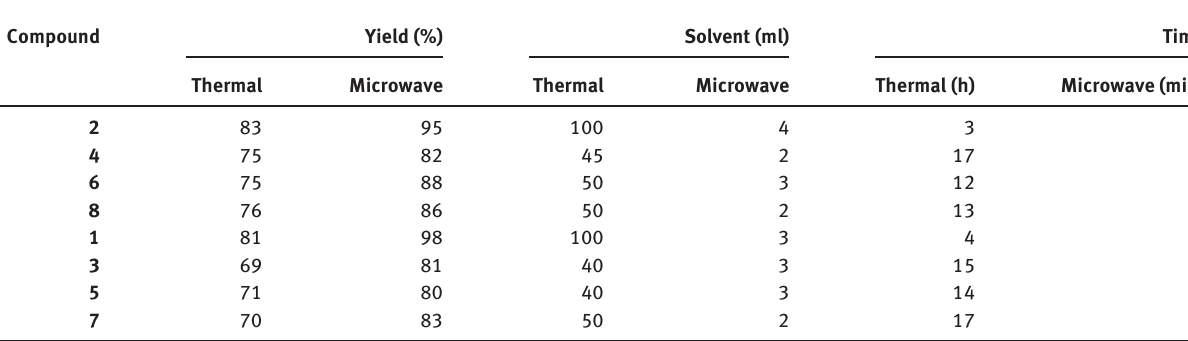
Table 5 Comparison between the microwave and thermal